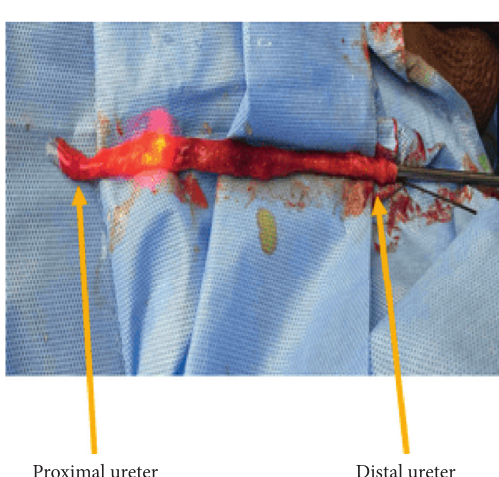
Figure 1: Complete (two-point) ureteral avulsions following semirigid